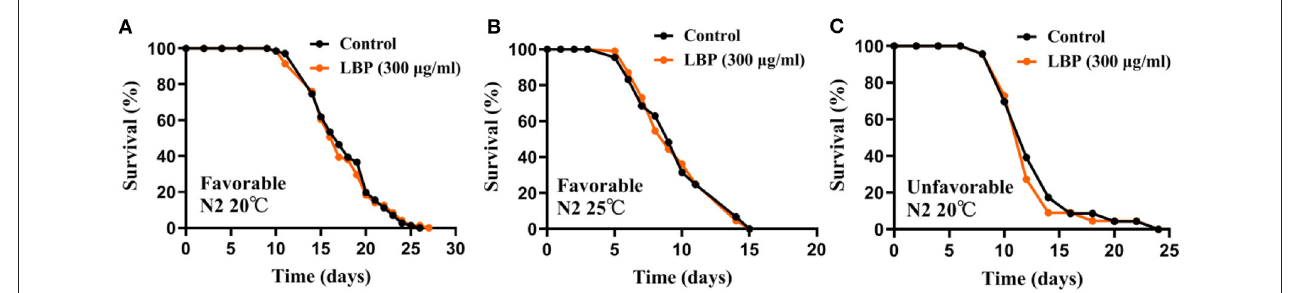
FIGURE 1 | LBP did not prolong the lifespan of worms at either 20 or 25 ◦ C. (A) Survival curves of N2 worms cultured with vehicle or 300 µ g/ml LBP at 20 ◦ C under favorable conditions (control: n = 71, mean lifespan 17.8 days; 300 µ g/ml LBP: n = 71, mean lifespan 17.3 days; p = 0.864). (B) Survival curves of N2 worms cultured with vehicle or 300 µ g/ml LBP at 25 ◦ C under favorable conditions (control: n = 89, mean lifespan 9.7 days; 300 µ g/ml LBP: n = 108, mean lifespan 9.7 days; p = 0.898). (C) Survival curves of N2 worms cultured with vehicle or 300 µ g/ml LBP at 20 ◦ C under unfavorable conditions (control: n = 23, mean lifespan 13.0